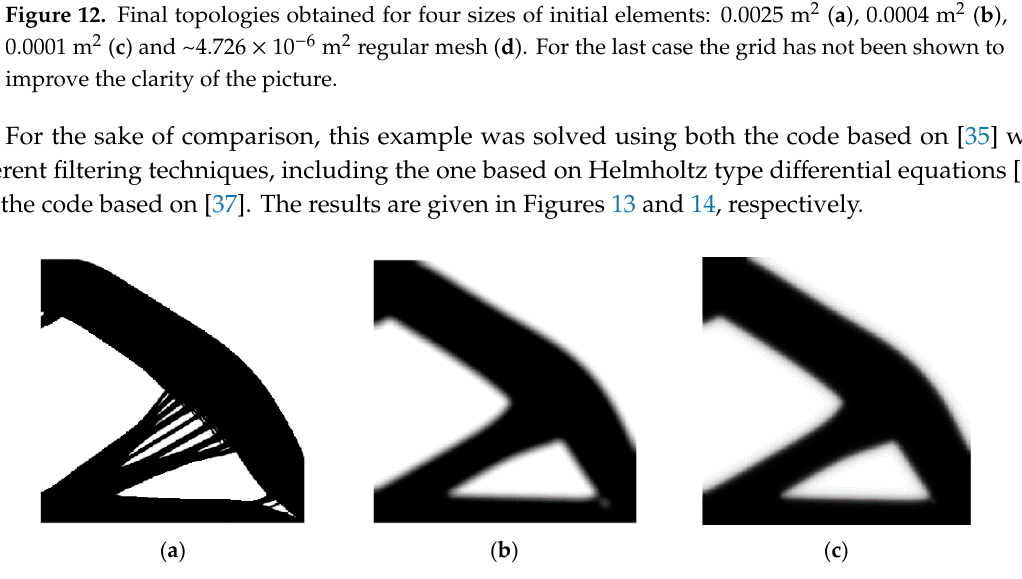
Figure 13. Final topology obtained using [35] with a small ( a ) and a large filtering radius. Case ( b ) refers to density filtering, whereas case ( c ) is the result of application of filtering based on Helmholtz-type differential equations.